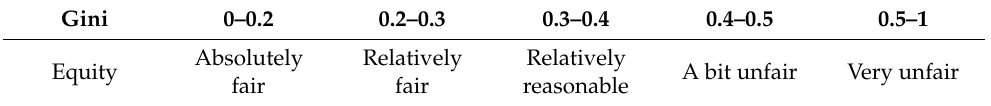
Table 2. The correspondence between the Gini coefficient and equity.